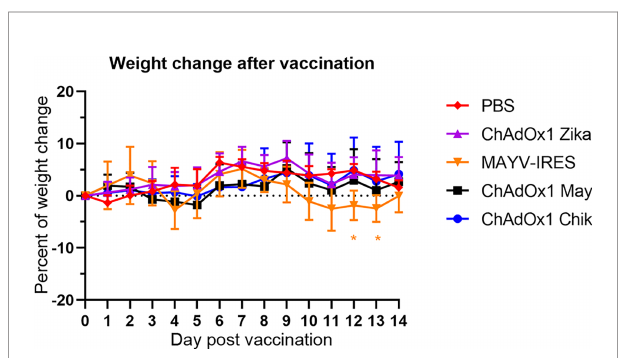
FIGURE 2 | Administration of ChAdOx1 vaccines do not cause weight loss in A129 mice. Percentages of weight change following vaccinations are shown. The weights of A129 mice in each group were compared to their weights just before vaccination (day 0). Data are represented as means and SEM. Two-way ANOVA with repeated measures with Dunnet ’ s compared with PBS group; *p < 0.05.